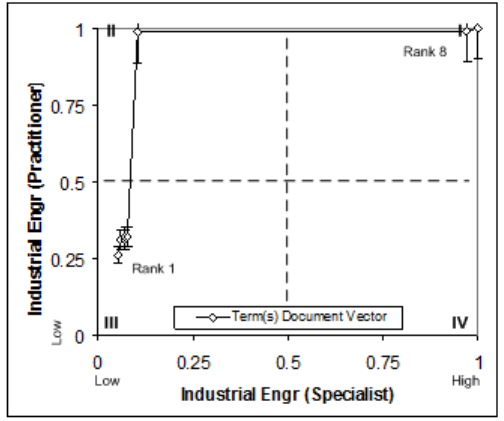
Figure 5. Toyota’s thinking for analyzing